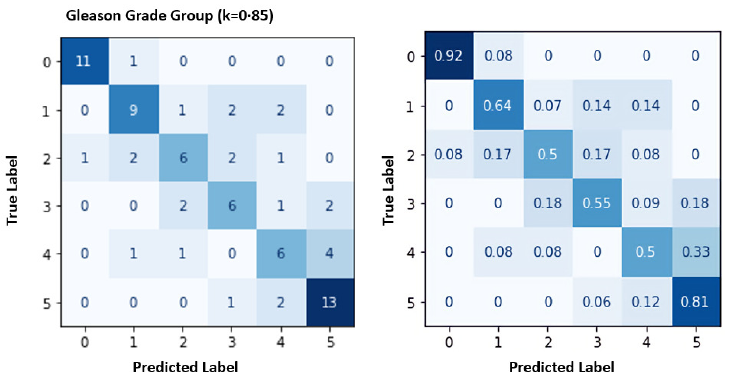
Figure 8. Confusion metrics for the grade groups results: cases number ( left ) and the percentage ( right